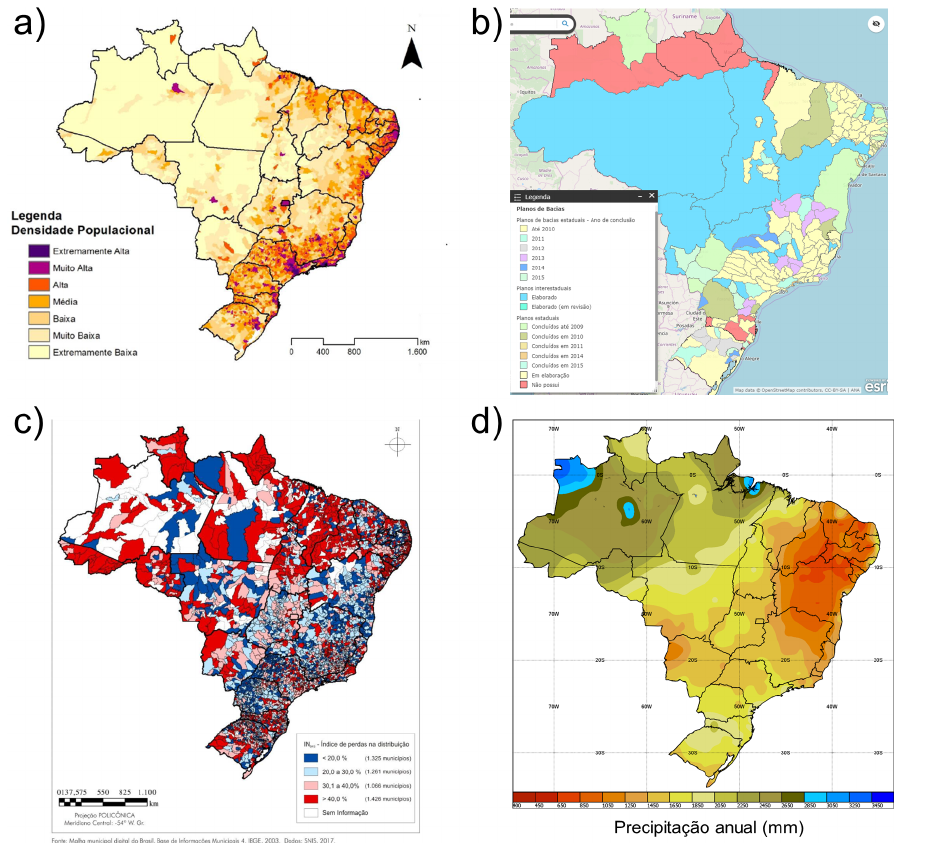
Figure 4. Example of a map collection used for mapping climate risk associated with water scarcity. The maps illustrate (a) population density (MMA, 2017), (b) stage of implementation of the water resources planning (Planos de Recursos Hídricos, 2020), (c) water distribution loss index (Brasil, 2017), and (d) annual rainfall (Normais climatológicas do Brasil,